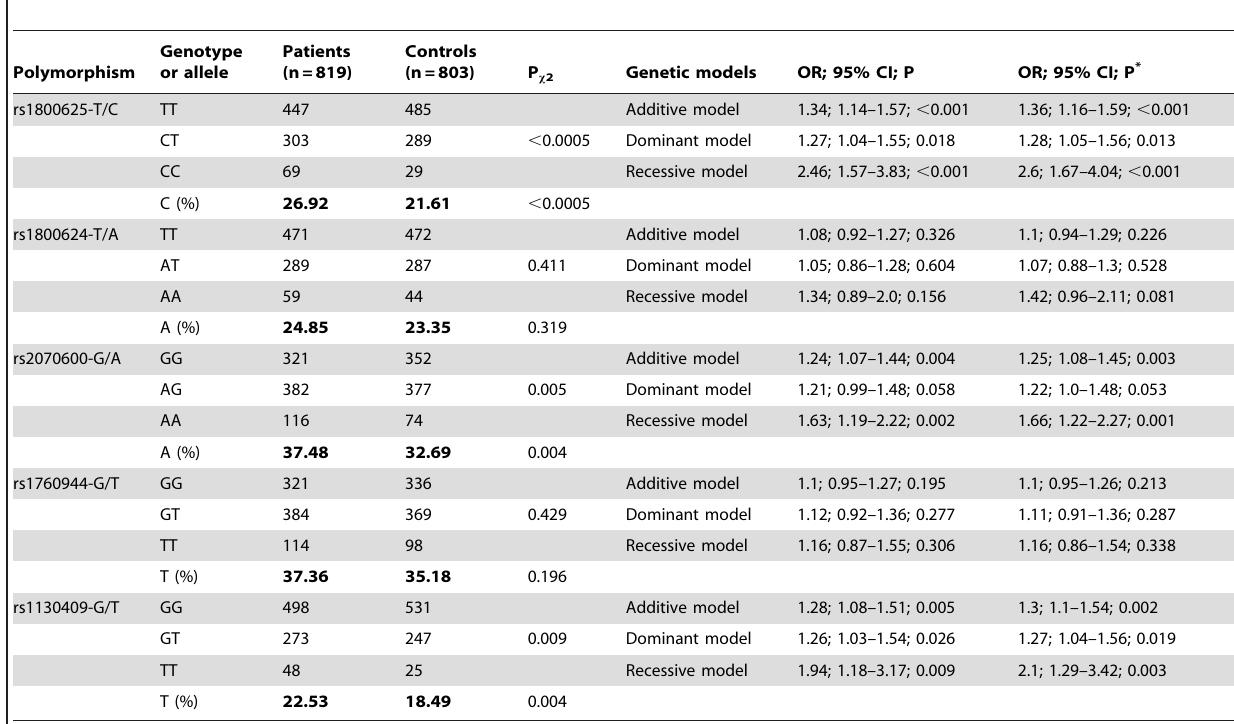
Table 2. Genotype distributions and allele frequencies of five examined polymorphisms between lung cancer patients and controls, as well as the risk prediction under additive, dominant and recessive genetic models.